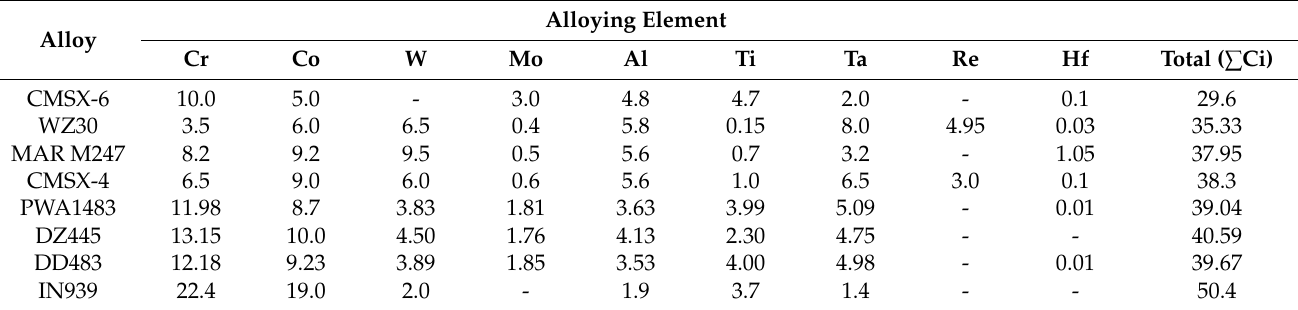
Table 1. Composition of the eight selected Ni-based superalloys (wt%).